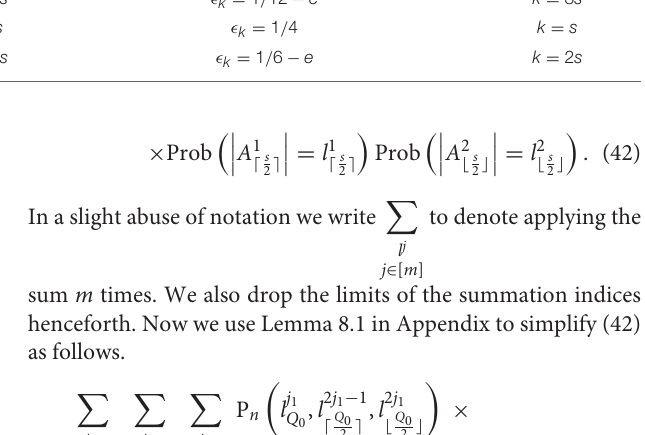
2 5 , ǫ as in the fourth column of Table 1 with e =